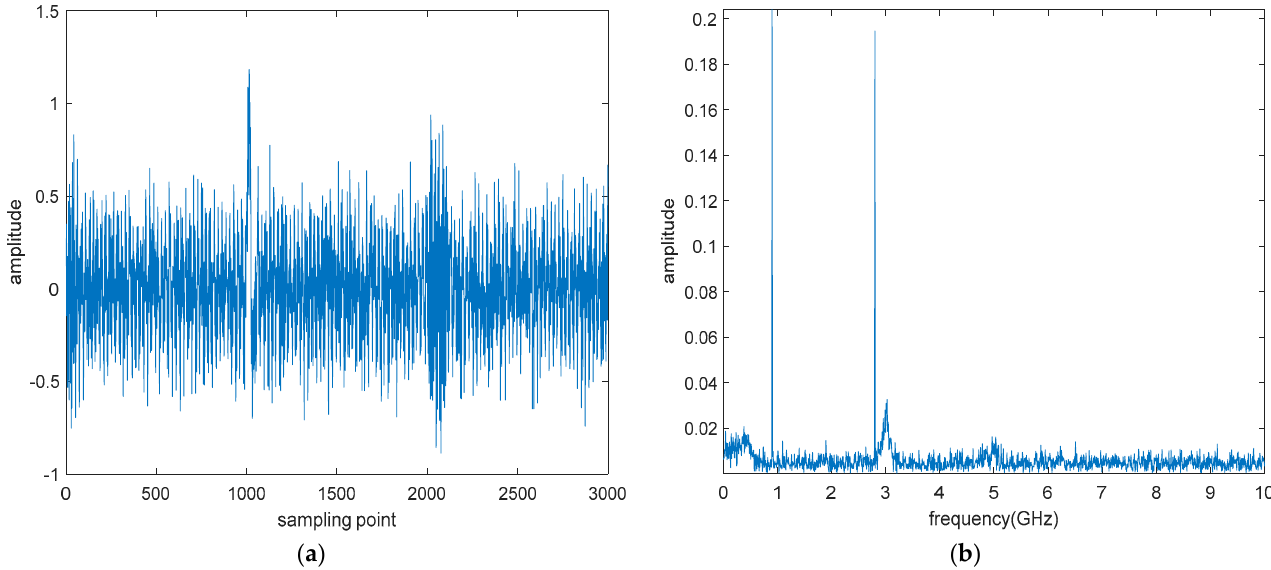
Figure 9. Noisy PD with both sinusoidal noise and white noise. ( a ) In the time domain and ( b ) in the frequency domain.